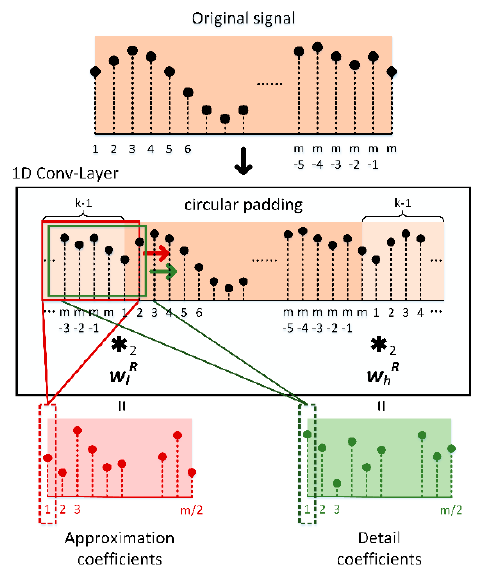
Figure 3. Single-level wavelet packet transform implemented in the 1D convolutional layer (Conv-Layer).